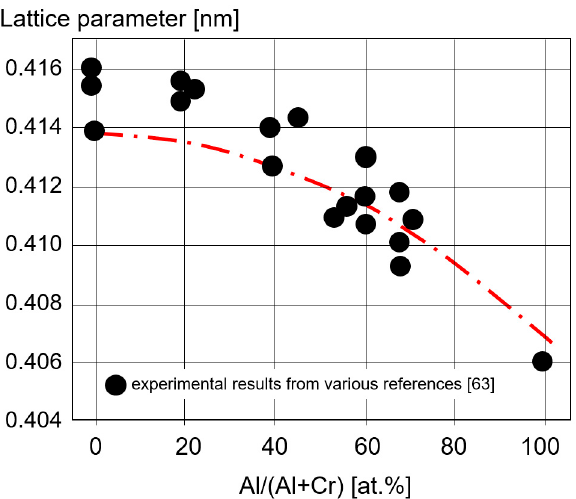
5 Figure 5. Lattice parameter calculated ab initio for CrN, (CrAl)N, (AlCr)N, and AlN coatings and experimentally measured XRD values, redrawn after [63], original © Elsevier.